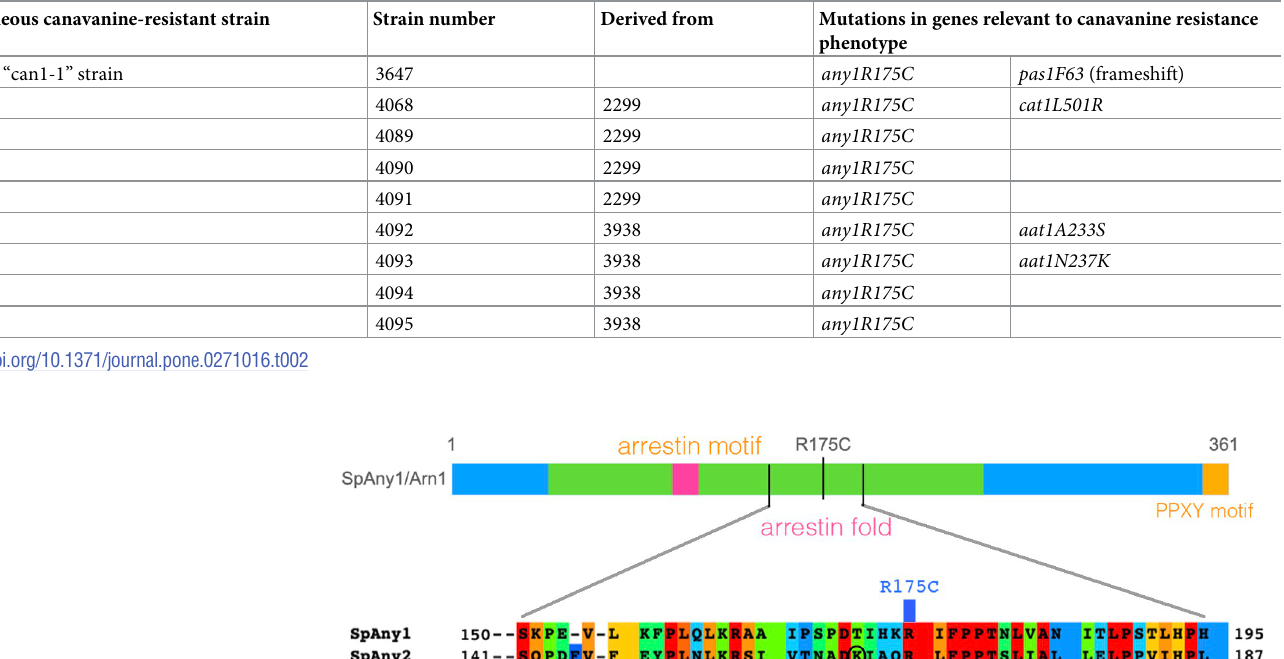
Table 2. Genes mutated in spontaneous canavanine-resistant mutants.